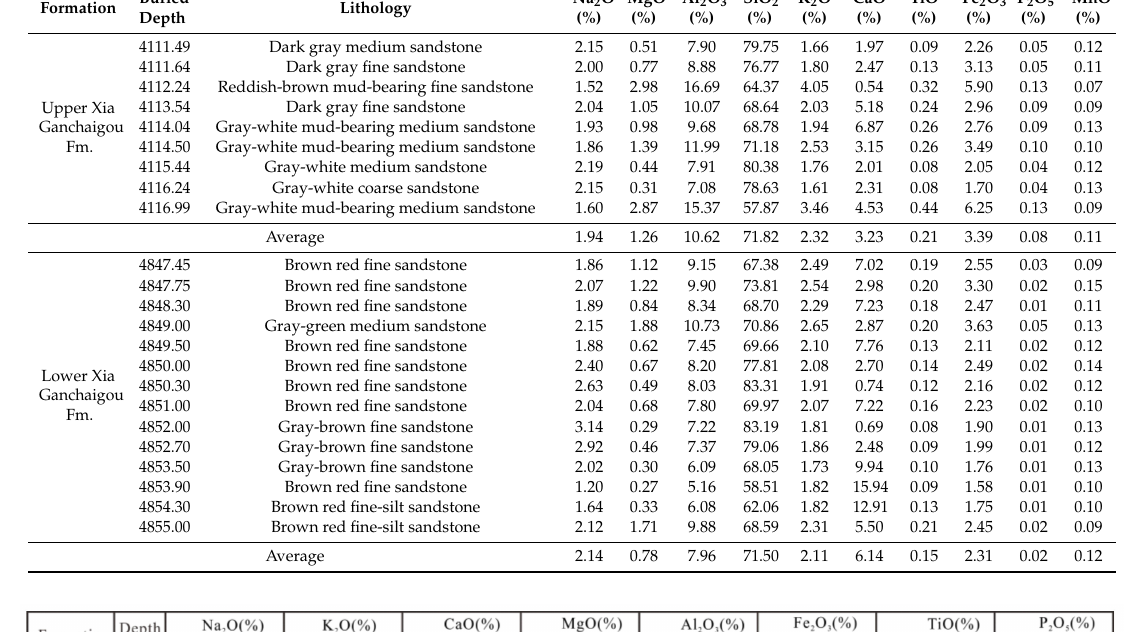
Table 2. Major oxide contents of the Xiaganchaigou Formation in the Lenghuqi structural belt. Formation Buried Depth